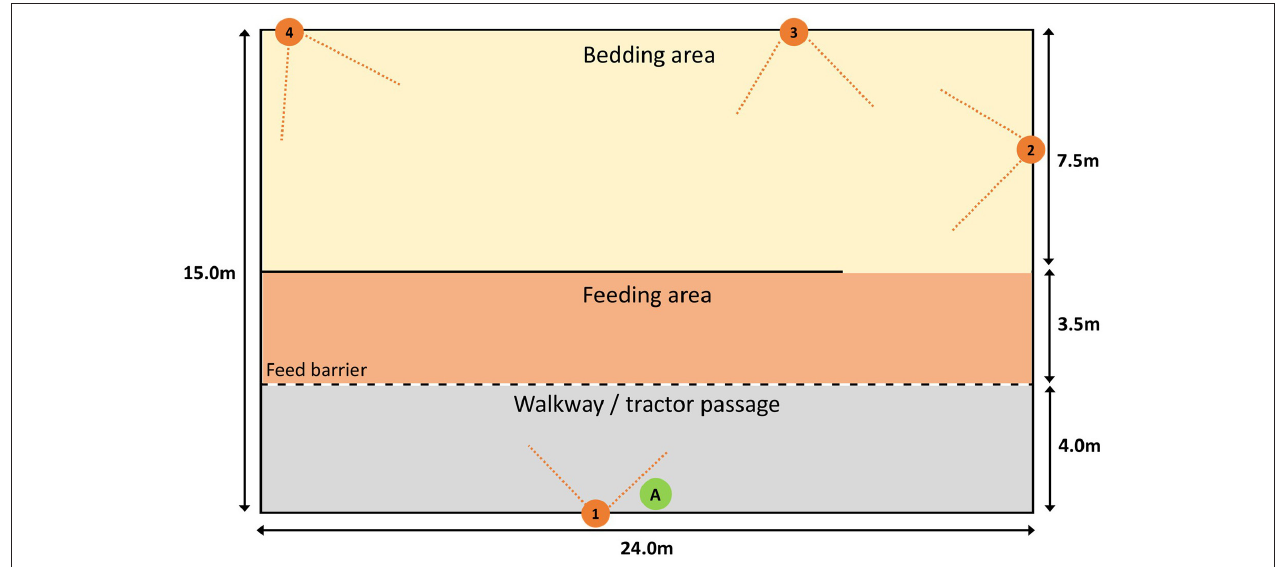
FIGURE 1 | Schematic of the barns, including approximate camera positions and field of view angles (orange). Camera numbers and positions are notated by orange numbered circles (1–4) with the approximate field of view indicated by dashed lines. Cattle had access to the bedding and feed areas, feed was placed in the walkway, the other side of the feeding barriers that separated the feeding area and walkway. The assessor stood by the wall at the bottom of the tractor passage, primarily at the point labelled “A” in the green circle. They were permitted to calmly move along that wall should it be required to gain a better view.